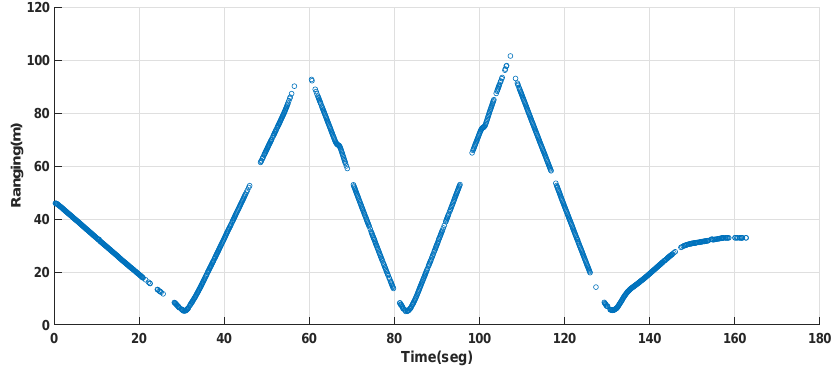
Figure 12. UWB ranging estimates after post-processing.